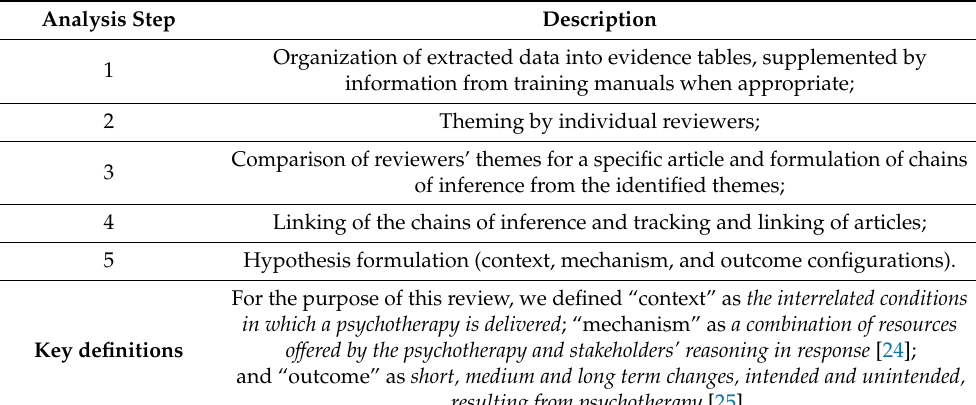
Table 2. Realist-informed